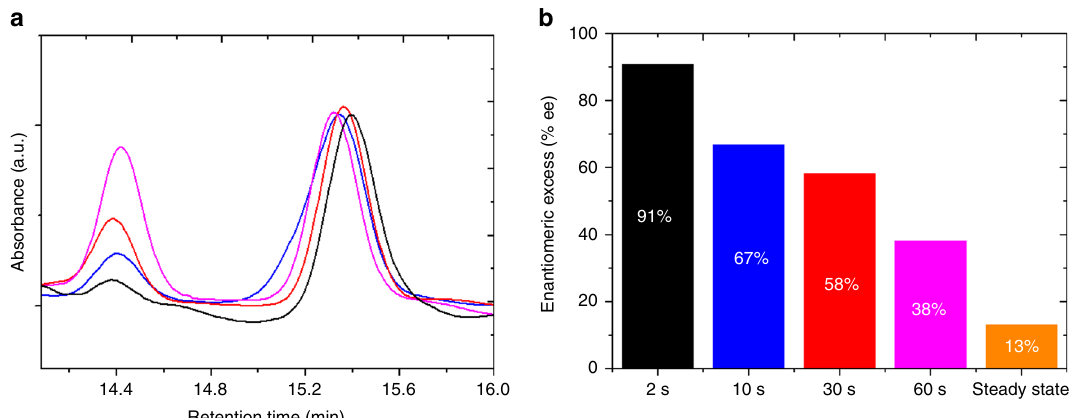
Fig. 5 Monitoring of enantioselectivity as a function of pulse time. a HPLC chromatograms of the electrosynthesis products obtained with an electrode imprinted with (S) -PE ( (S) -PE/PtCl 6 2 − weight ratio of 0.15) at − 0.45 V for different pulse times; 60 s pulse time (pink), 30 s (red), 10 s (blue) and 2 s (black), with 120 s relaxation time in all cases. The peaks at retention times of 14.4 and 15.3 min belong to (R) -PE and (S) -PE, respectively; b Histogram of the relationship between enantiomeric excess and pulse time using the same color code and showing for comparison also the value obtained in a